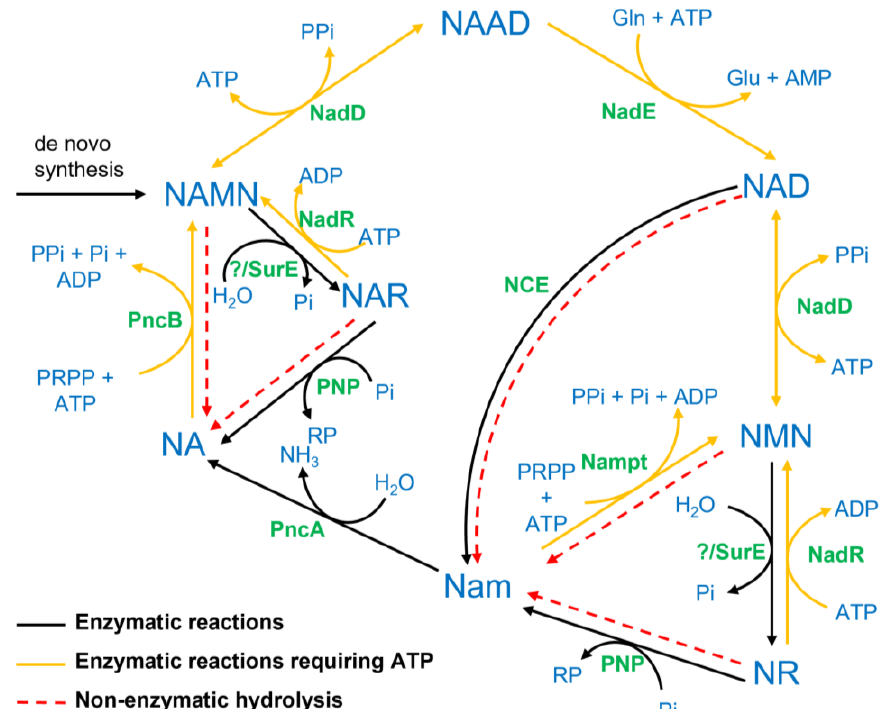
Figure 1. Schematic representation of reactions involved in the biosynthesis of NAD in different organisms. Metabolite names are written in bold blue letters, while the enzyme names are denoted in green colour. The abbreviation NCE (NAD-consuming enzymes) represents all enzymes catalysing signalling reactions consuming NAD. The bold black lines represent enzyme-catalysed reactions, whereas the dotted red lines denote non-enzymatic hydrolysis, mainly occurring at high temperatures. Bold yellow lines are used to denote reactions that require ATP. Whether the bacterial 5 ’ -nucleotidase SurE accepts NMN/NAMN as substrate is unknown; a homologue to the mammalian NT5 could not be identified in bacteria. NAD, Nam adenine dinucleotide; NMN, Nam mononucleotide; NR, Nam riboside; NA, nicotinic acid; NAR, NA riboside; NAMN, NA mononucleotide; NAAD, NA adenine dinucleotide; NadD, NA/NMN adenylyltransferase; Nampt, Nam phosphoribosyltransferase; NadR, NA/Nam riboside kinase; SurE, 5 ′ -nucleotidase; PNP, purine nucleoside phosphorylase; PncA, nicotinamidase; PncB, NA phosphoribosyltransferase; NadE, NAD synthase.